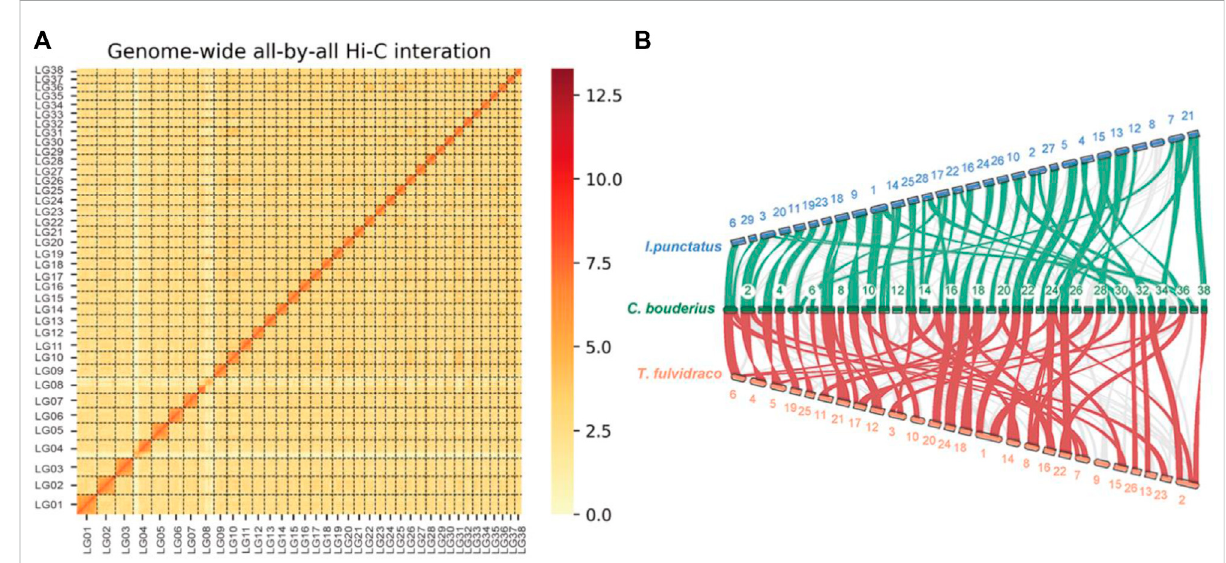
FIGURE 1 Characteristics of the Cranoglanis bouderius genome. (A) A Hi-C contact map of the C. bouderius genome. LGs 1 – 38: Lachesis groups 1 to 38, representing the 38 chromosomes of C. bouderius . (B) Gene collinearity between C. bouderius and the two related fi sh species Tachysurus fulvidraco and Ictaluruspunctatus .Thegreenandredlinksdenoteblockscoresexceeding 200between I.punctatus and C.bouderius ,andbetween C. bouderius and T. fulvidraco , respectively. C. bouderius chromosomes are numbered in ascending